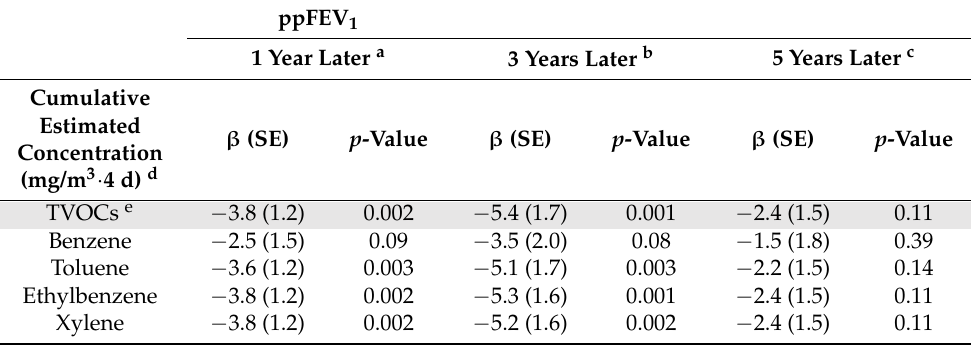
Table 3. Cross-sectional associations between exposure to VOCs and loss of lung function 1 year, 3 years, and 5 years after the very high environmental exposure to VOCs from the Hebei Spirit oil spill (n = 224). ppFEV 1 1 Year Later a 3 Years Later b 5 Years Later c Cumulative Estimated β (SE) p -Value β (SE) p -Value β (SE) p -Value Concentration (mg/m 3 · 4 d) d TVOCs e − 3.8 (1.2) 0.002 Toluene